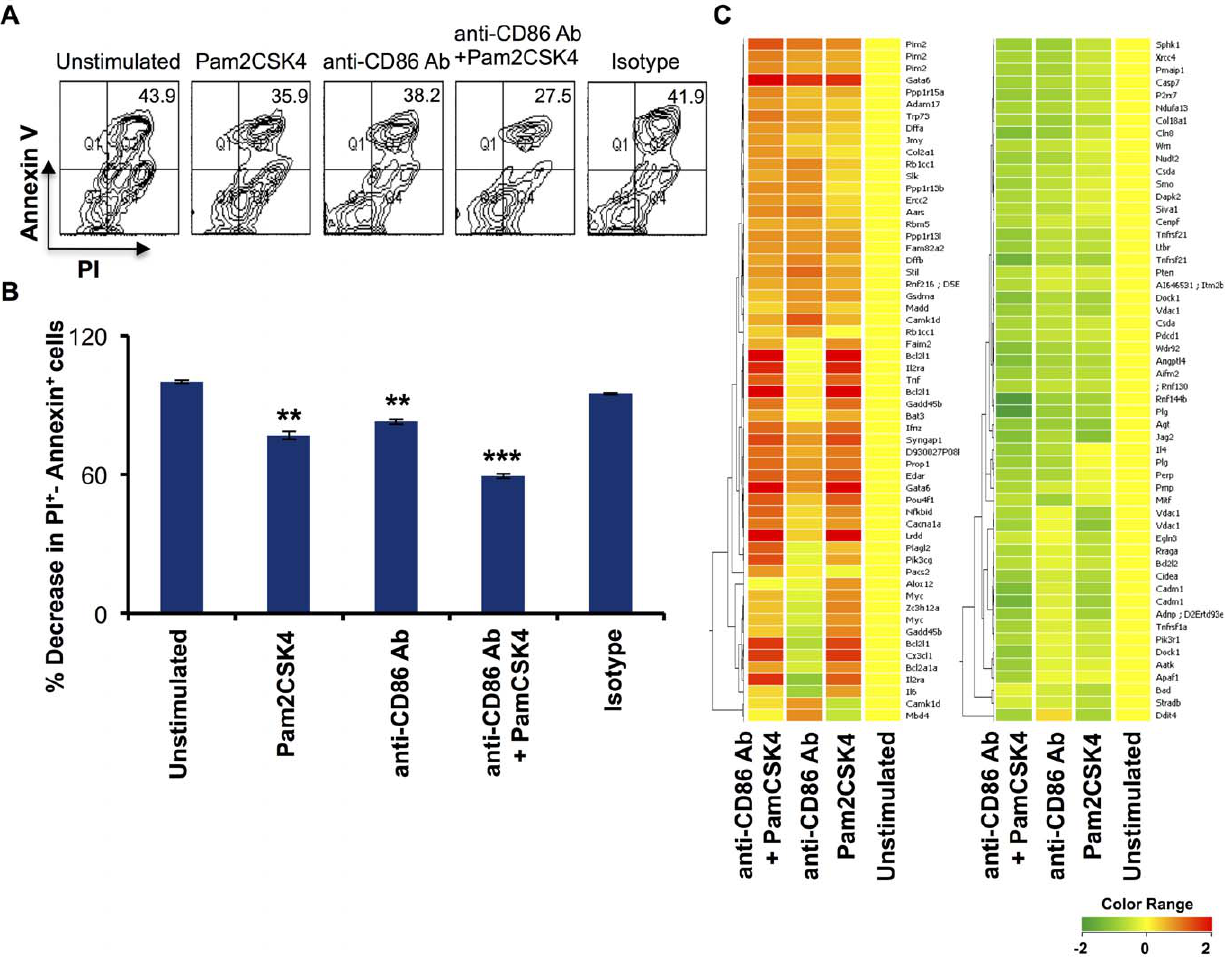
Figure 2. Concomitant signaling of CD86 and TLR-2 reduces the percentage of RB cells undergoing apoptosis. RB cells isolated from BALB/c splenocytes were stimulated by anti-CD86 Ab and Pam2CSK4 for 72 h and apoptosis was checked by PI-Annexin V staining. (A) Flowcytometry density plots show the representative PI-Annexin double positive cell population; (B) bar diagrams indicate percentage change in PI- Annexin double positive population with respect to controls (PI-Annexin double positive cells of unstimulated cells taken as 100%). Flowcytometry data expressed as mean 6 SEM were representative of 3 independent experiments. Statistical analysis was done by Student‘t’ test and ‘**’, ‘***’ indicate p , 0.01 and p , 0.001 respectively; (C) dendrograms represent modulation in the expression of genes encoding for molecules involved in apoptosis. Left panel indicates upregulated genes, whereas right panel signify downregulated genes. Scale bar: 2 2 to + 2.